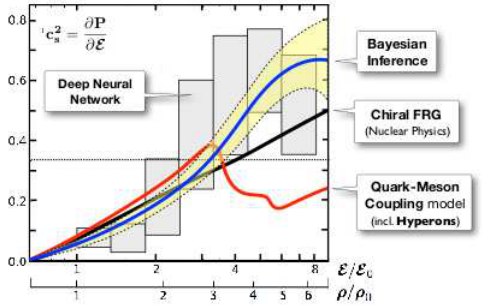
Figure 5. Squared speed of sound in neutron star matter as function of energy density (in units of ε 0 = 150 MeV / fm 3 ) and of baryon density (in units of ρ 0 = 0 . 16 / fm 3 ). Bayes inference result (68% credible band) [16] is shown side-by-side with data-based mapping of c 2 using a deep learning network approach s [30]. For comparison: chiral nucleon-meson fi eld theory combined with functional renormalization group (Chiral FRG) [21], and quark-meson coupling model calculation including hyperons